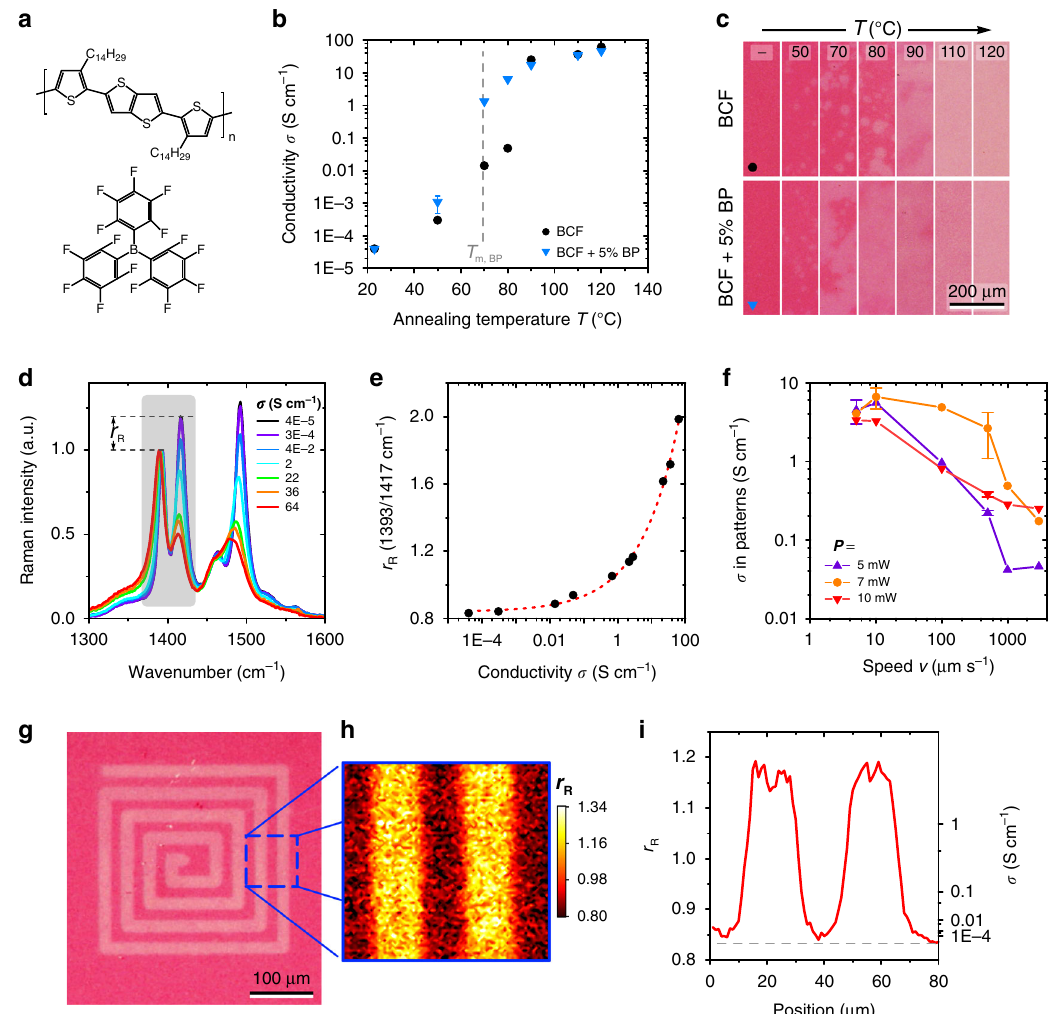
Fig. 4 Electrical conductivity patterning in PBTTT fi lms by local doping. a Chemical structures of PBTTT and BCF. b Conductivity σ of PBTTT fi lms doped through gate by annealing for 1 min at temperature T . Solution-deposited dopant layers comprised BCF (black dot) and BCF + 5 wt% biphenyl ( ‘ BP ’ ; blue triangle) added as a co-solvent. Dashed line indicates the melting temperature of BP. c Transmitted-light micrographs for the fi lms in b . d Selected Raman spectra of doped PBTTT fi lms, with conductivities indicated. Spectra are normalised by the intensity of the peak at ~1393 cm − 1 ; shaded region highlights the peaks used for estimating conductivity. e Raman intensity ratio r R of the maximum intensities of the ~1393 cm − 1 and ~1417 cm − 1 peaks of PBTTT as a function of σ . Dotted line indicates a curve fi t to the data. f Maximum conductivities obtained in line patterns of doping induced by scanning laser excitation at 532 nm for the indicated incident power P and writing speed v . Conductivities were extracted by Raman mapping of r R using the calibration data in e . g Transmitted-light micrograph of laser-patterned ( P = 7 mW, v = 3 μ m s − 1 ) RFID-antenna-type structure. h Raman map of r R for the indicated area and ( i ) the corresponding average pro fi les of r R (left ordinate) and σ (right